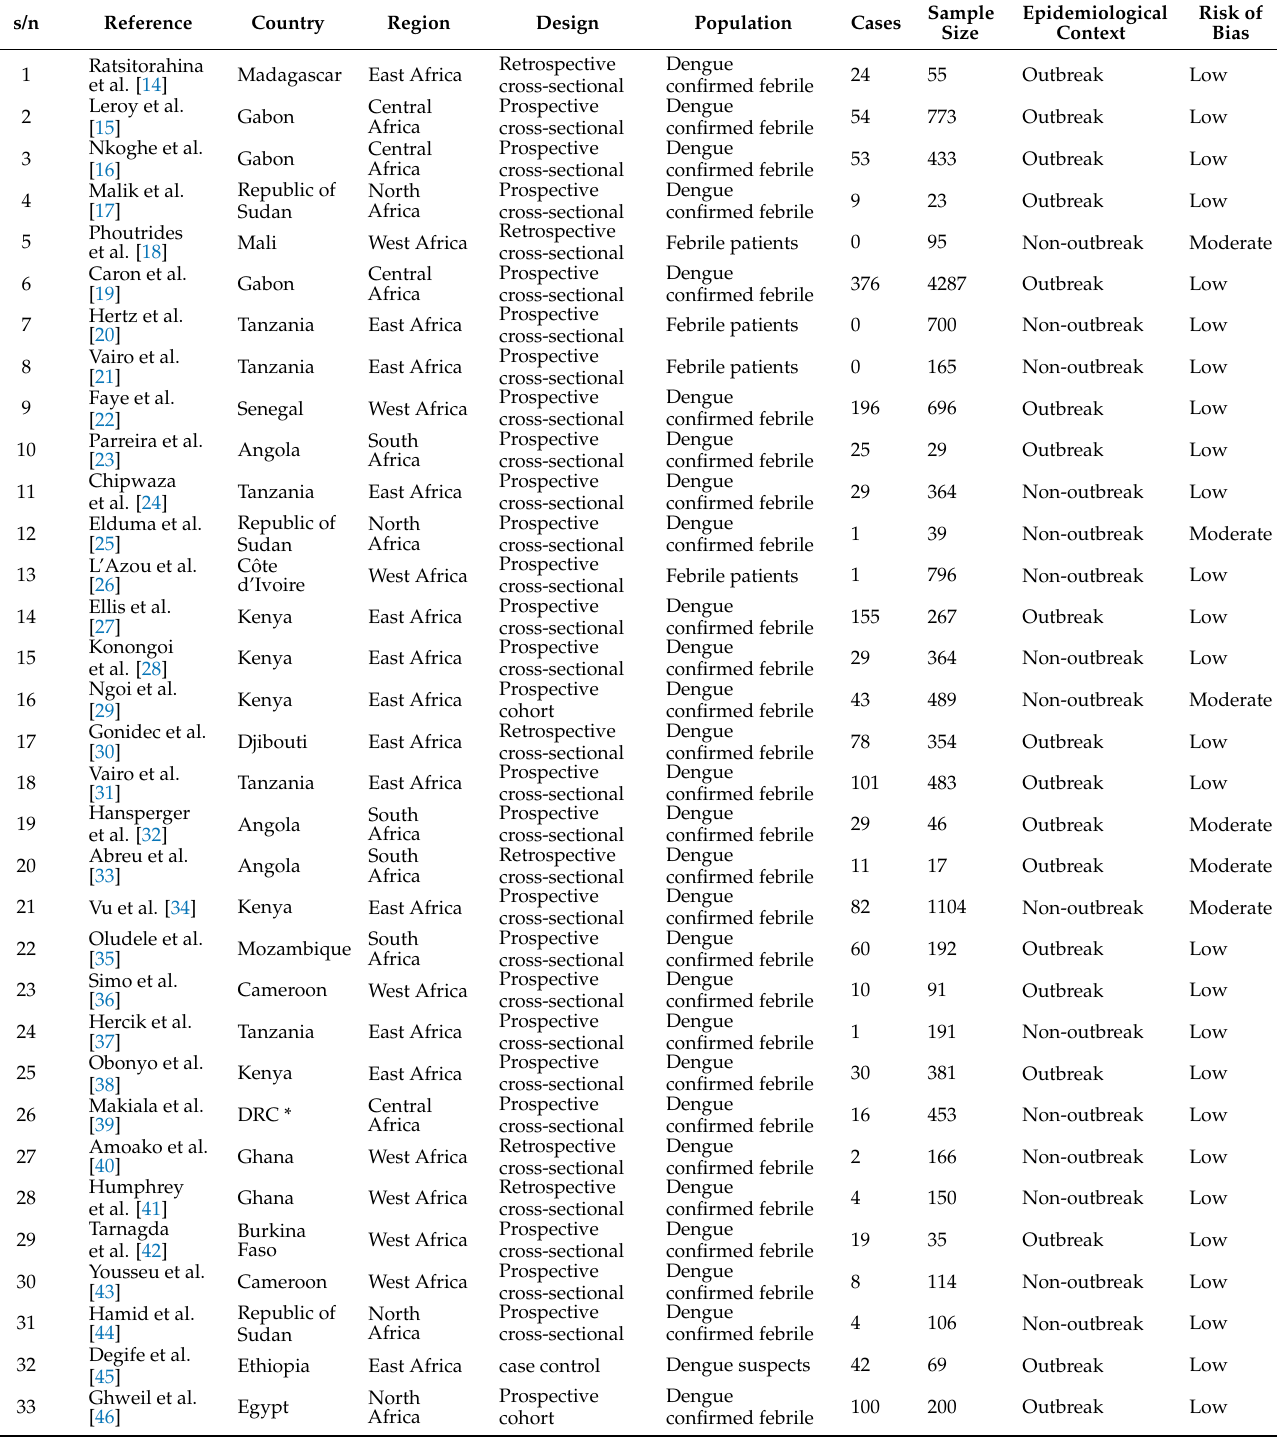
Table 1. The characteristics of studies included in the systematic review and meta-analysis by country, region, design, and